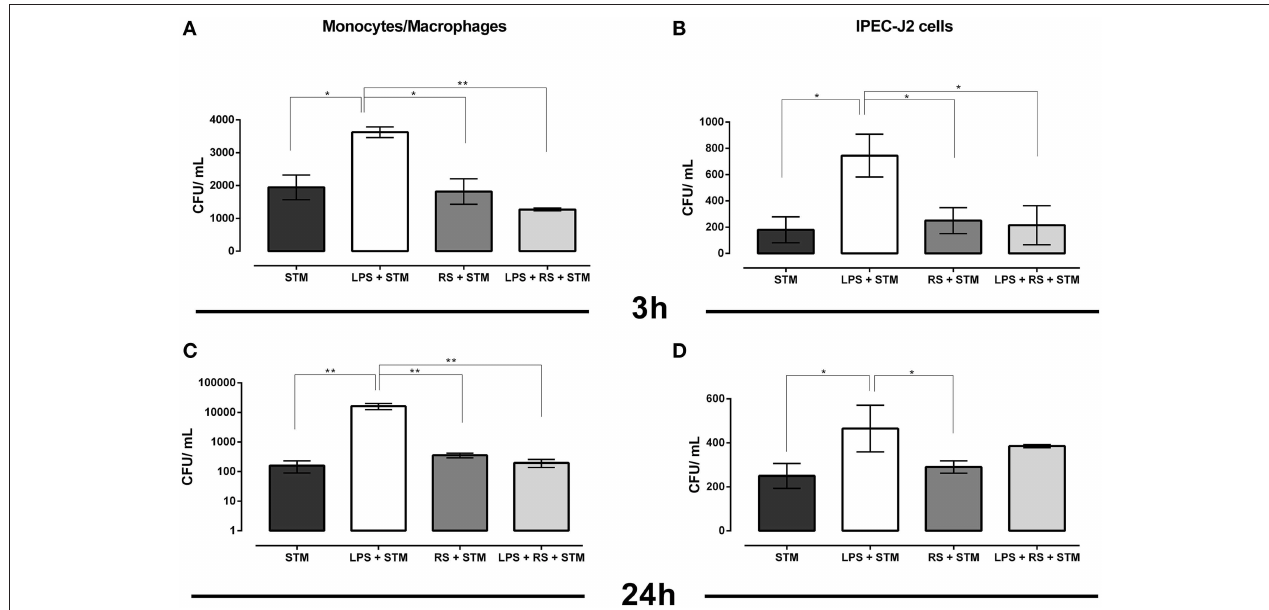
FIGURE 2 | STM14028 colonization of mono-macrophages and IPEC-J2 cells at 3 and 24h post infection (A–D). STM14028 colonization increases with LPS pre-treatment and is reduced by RS-LPS antagonist to the values of LPS-untreated cells ( * P ≤ 0.1 ; ** P ≤ 0.01 , One-Way Anova Turkey’s multiple comparisons test, data from one representative experiment out of three with similar results).